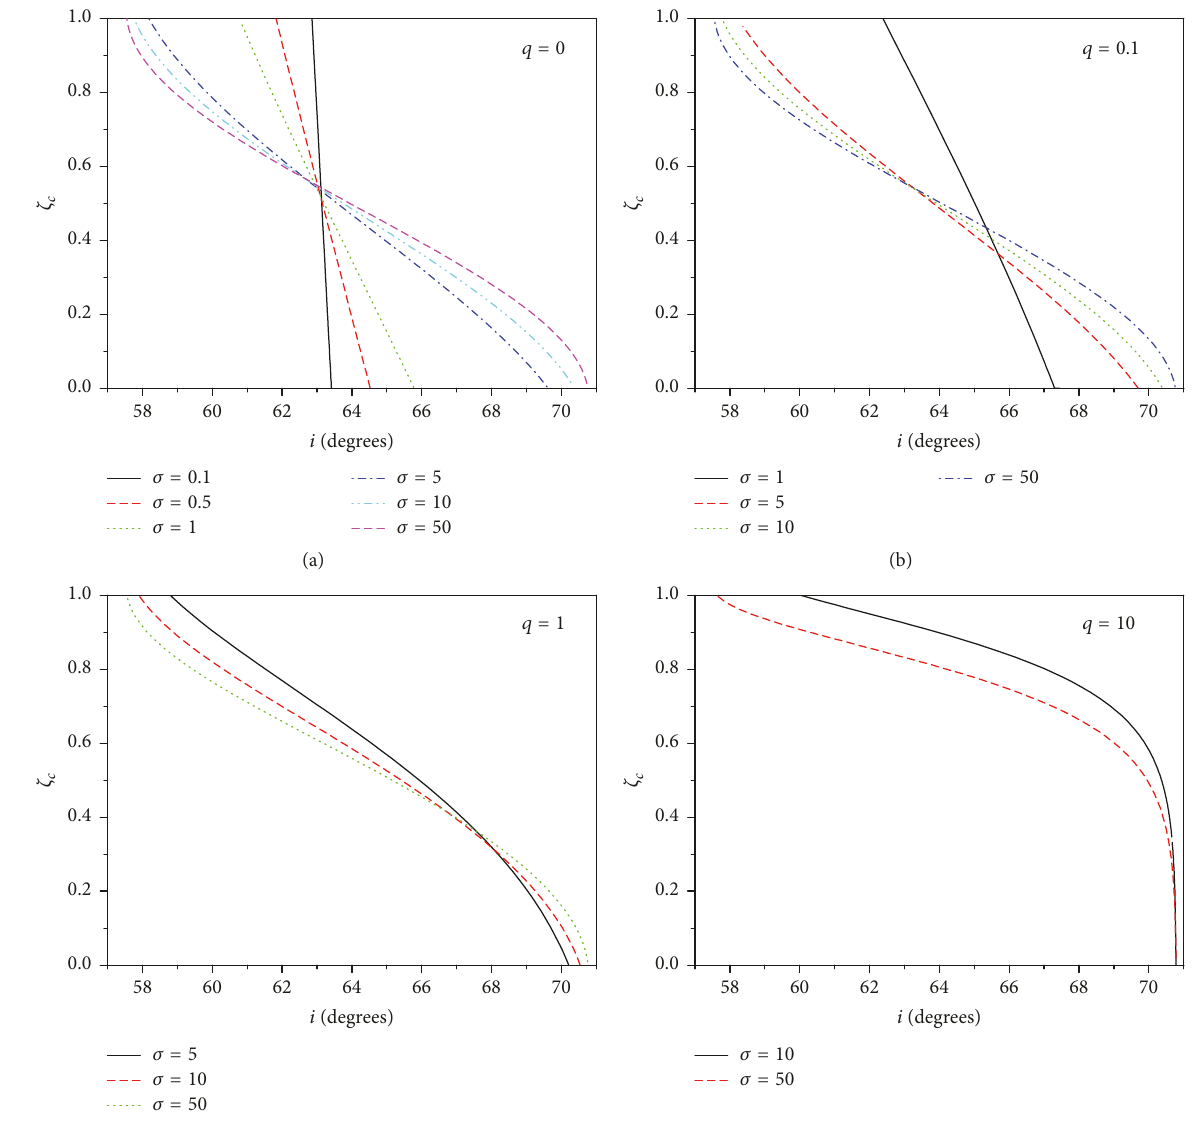
Figure 4: Ray penetration 𝜁 𝑐 as function of the angle of incidence for (a) 𝑞 = 0 , (b) 𝑞 = 0.1 , (c) 𝑞 = 1 , and (d) 𝑞 = 10